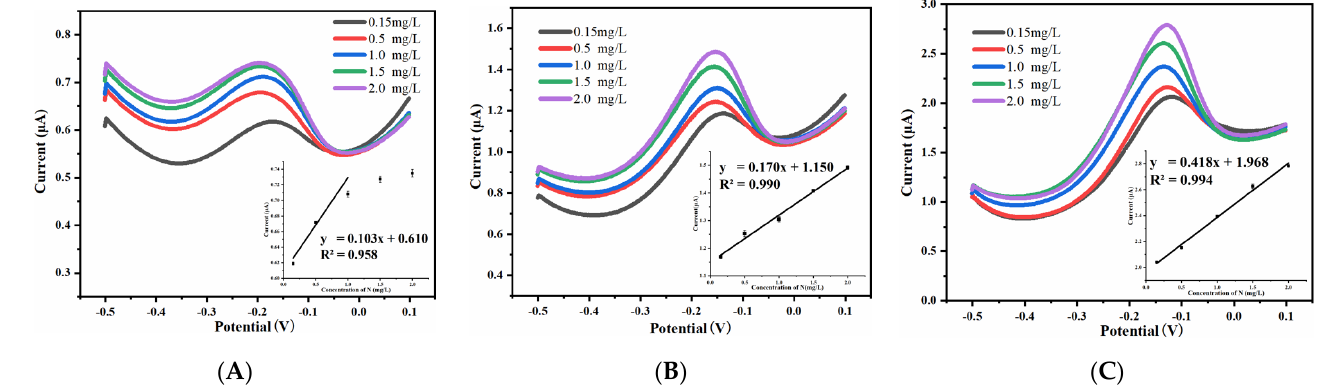
Figure 12. DPV response curves and the calibration curves (inset) of UIAE chips for NH 3 -N with different widths: ( A ) 1 5 μ m; ( B ) 10 μ m; ( C ) 5 μ m.